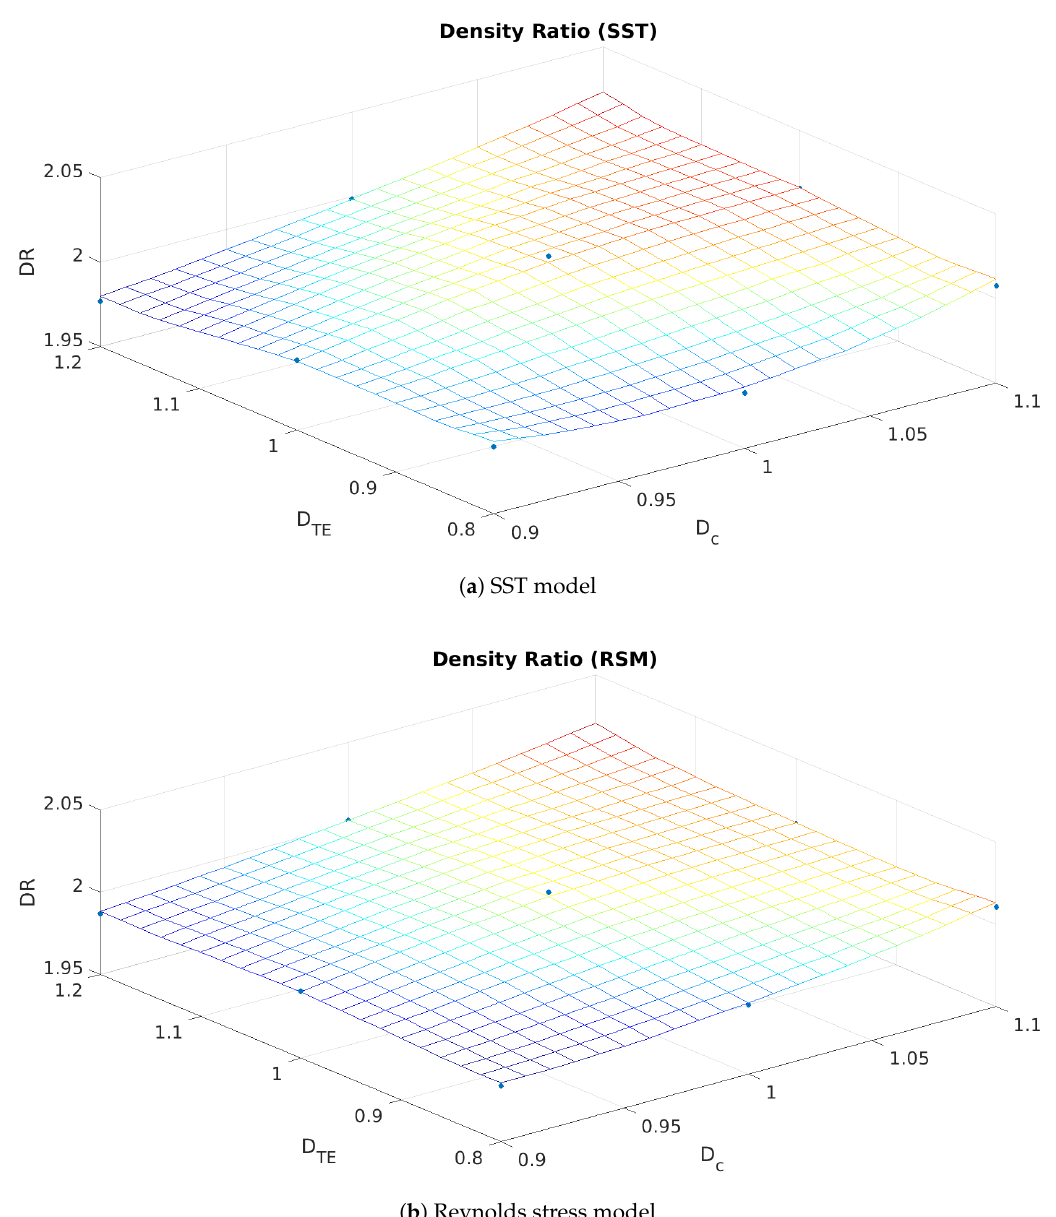
Figure 11. Density Ratio DR (Padè